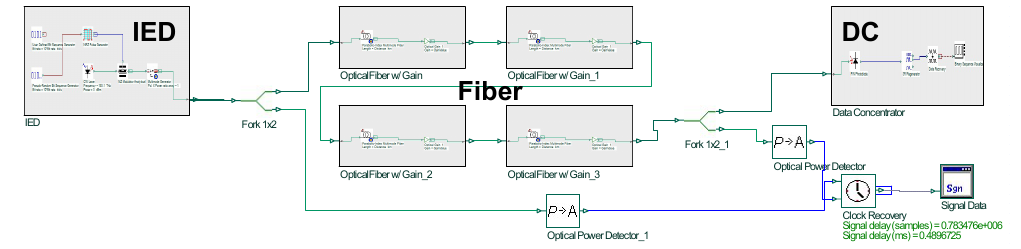
Figure 13. OptiSystems: 100 km P2P optical communication